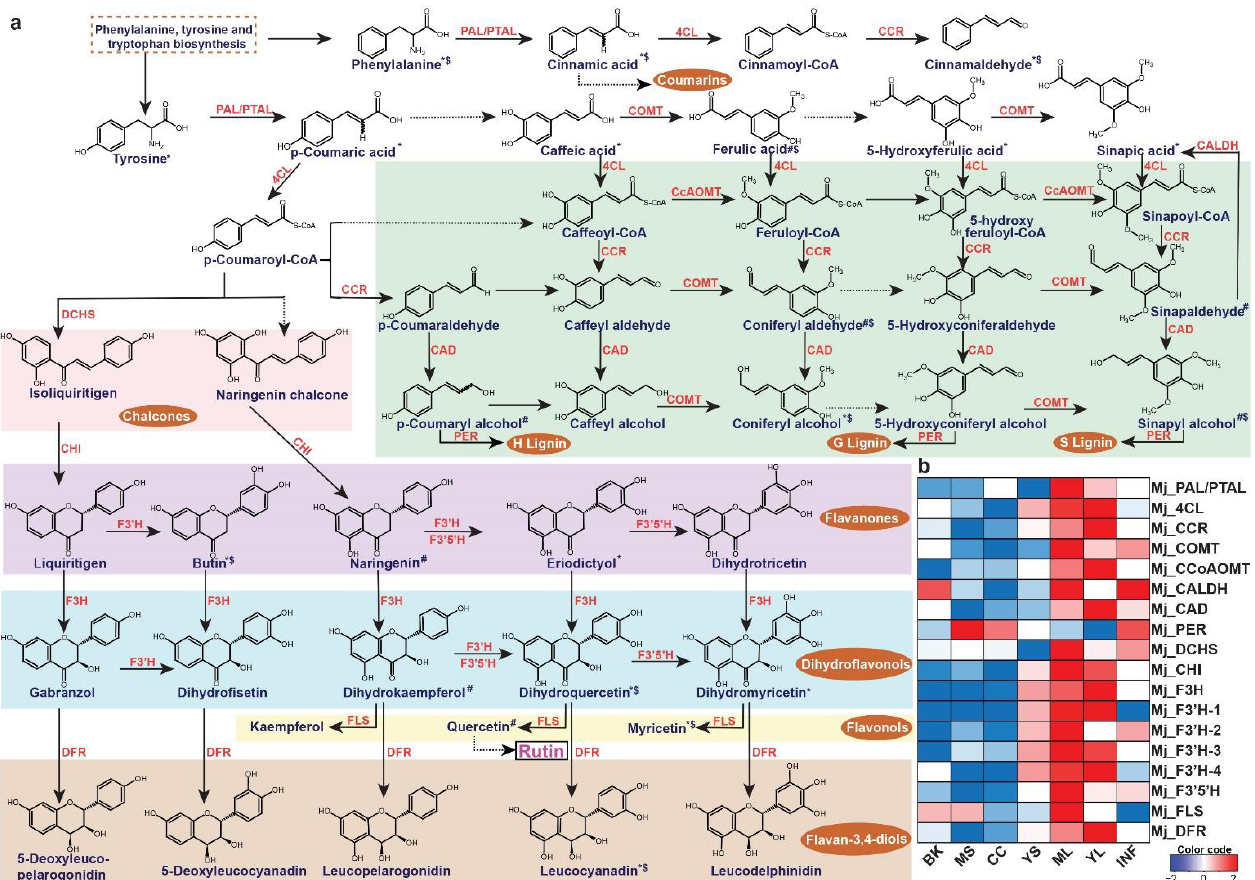
Figure 7. Unigenes associated with the biosynthesis of rutin and their expression levels across different tissues of Mallotus japonicus . ( a ) Proposed rutin biosynthetic pathway and related metabolites in M. japonicus . ‘*’, ‘#’, and ‘$’ represent the metabolite features mapped to the KNApSAcK database, KEGG database, and MS 2 -based fragmentation data in the M. japonicus metabolome database, respectively. ( b ) Heatmap representing the expression of transcripts assigned to the rutin biosynthetic pathway in M. japonicus . Abbreviations: PAL/PTAL: phenylalanine/tyrosine ammonia-lyase, 4CL: 4-couma- rate: CoA ligase, cinnamoyl-CoA reductase, COMT: caffeic acid OMT, CcoAOMT: caffeoyl-CoA OMT, CAD: cinnamyl alcohol dehydrogenase, PER: peroxidase, DCHS: 6′-deoxychalcone synthase, CHI: chalcone isomerase, F3H: flavanone-3-